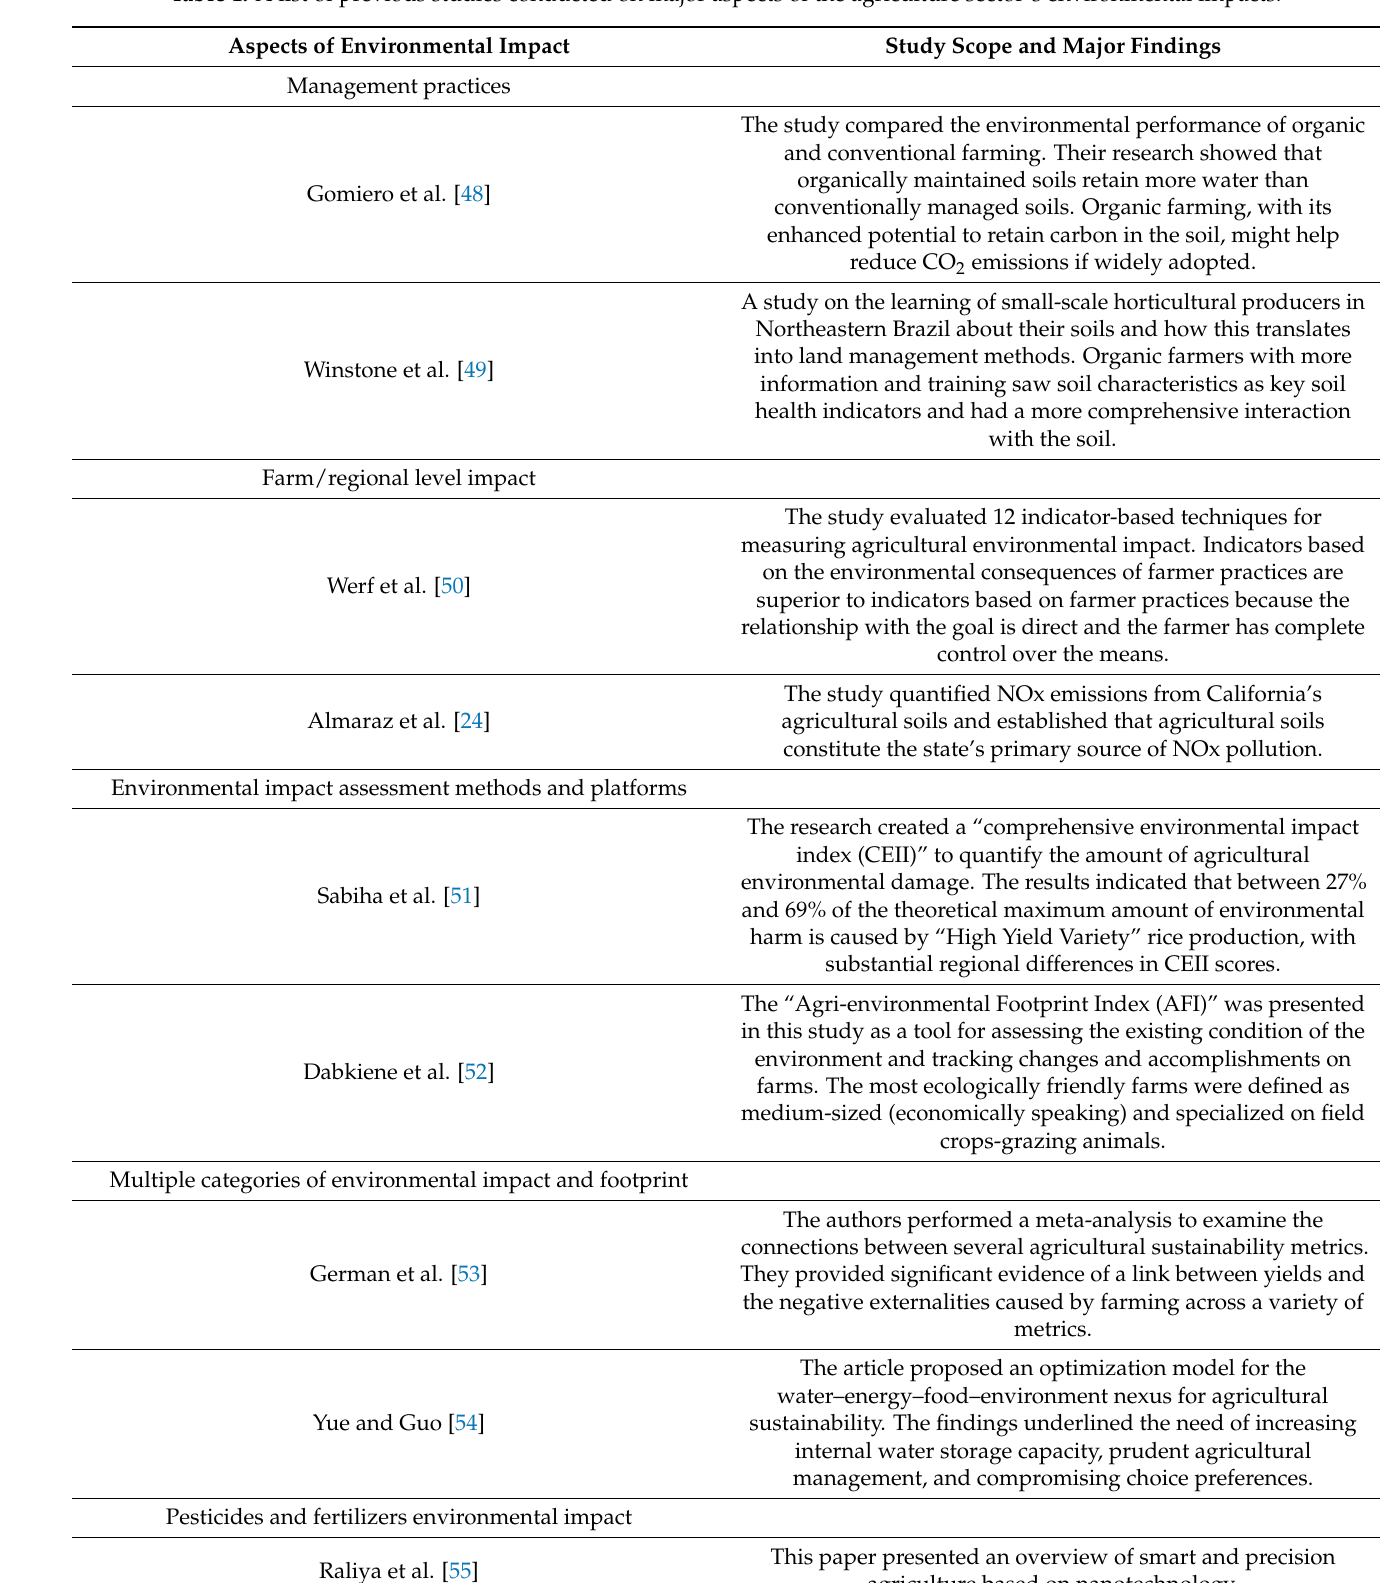
Table 1. A list of previous studies conducted on major aspects of the agriculture sector’s environmental